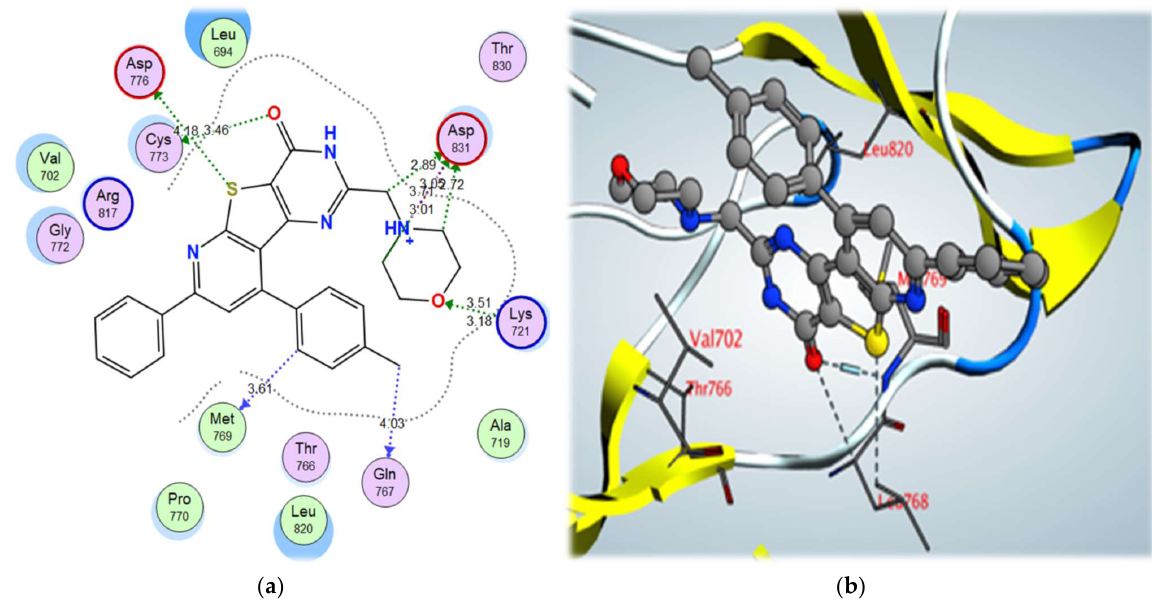
Figure 8. ( a ) 2D interactions and ( b ) 3D interactions of compound 5a within the EGFR kinase domain’s active site.